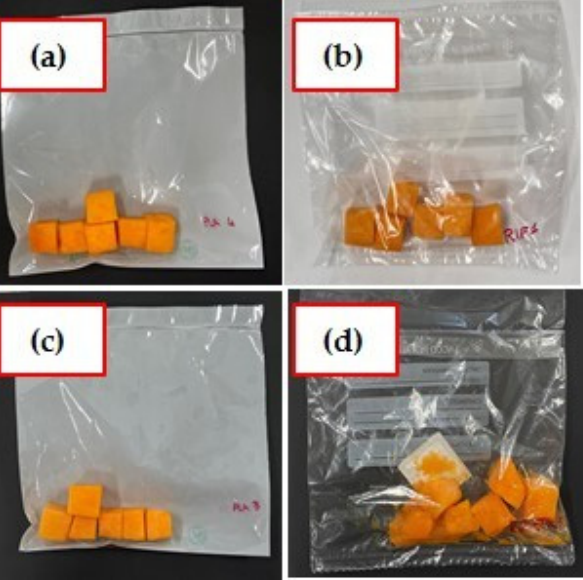
Figure 8. Pictures of pumpkins stored in biofilm C and in REF packaging at time 0 and after 11 days. ( a ) C at 0 days; ( b ) REF at 0 days; ( c ) C at 11 days; ( d ) REF at 11 days.